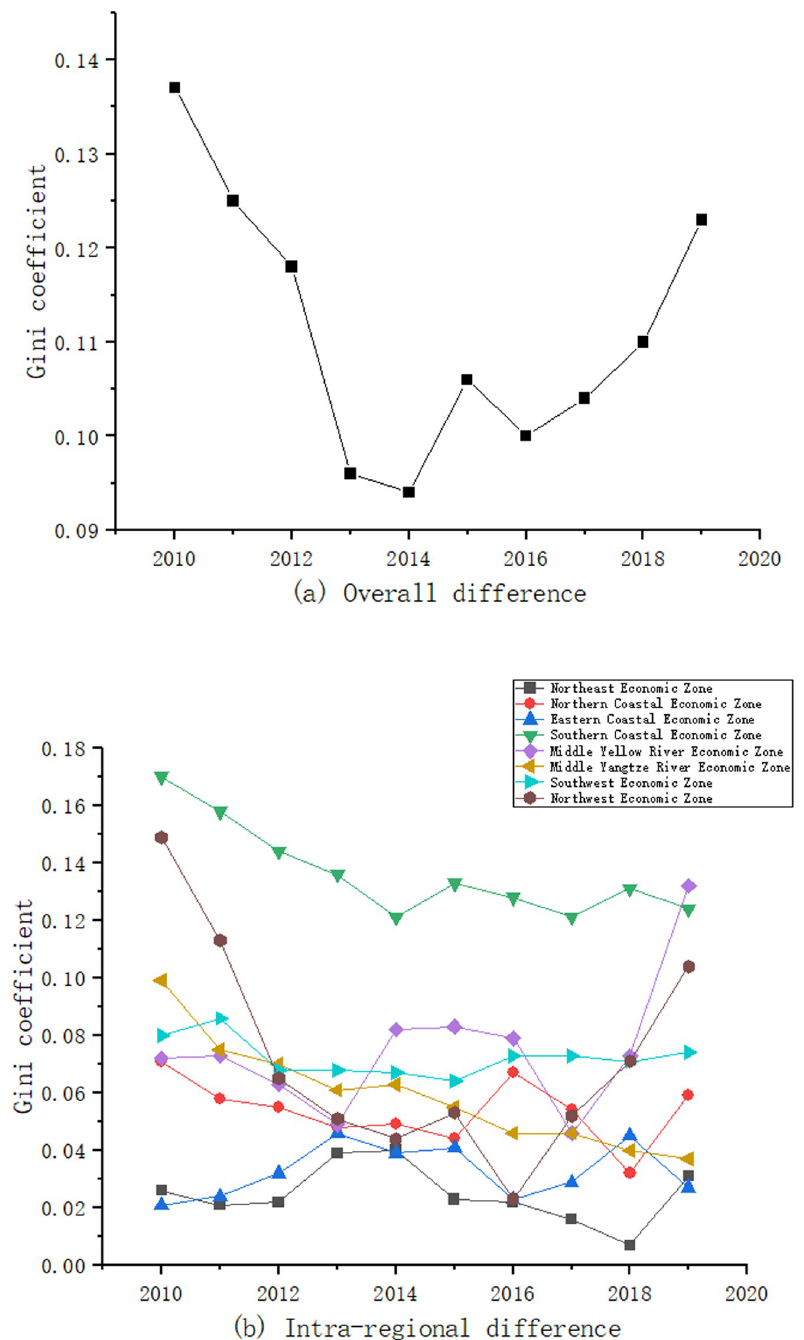
Fig 5. Overall and intra-regional differences of coupling coordination degree of energy-economy-carbon emission system.